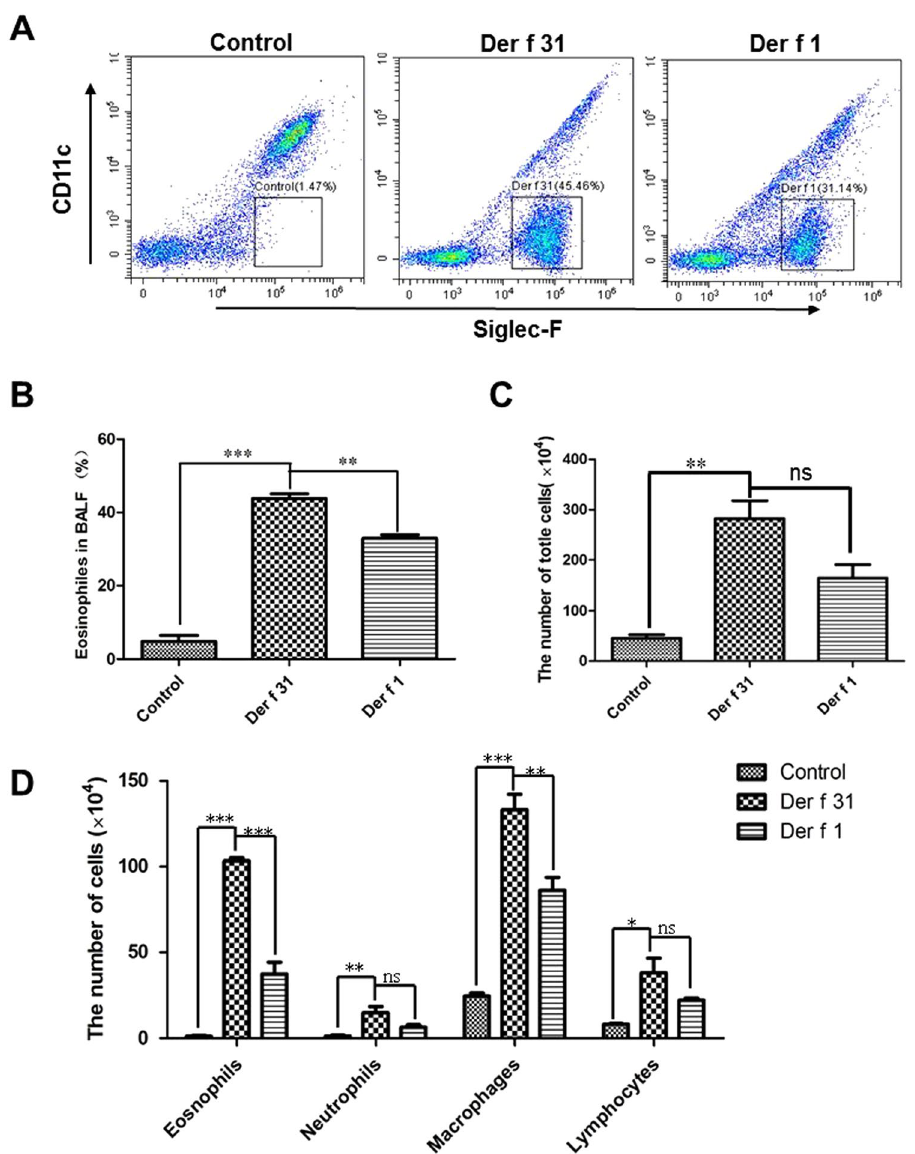
Figure 6. Der f 31 triggers an eosinophilia. ( A ) representative flow profile of Siglec-F + eosinophils in BALF. ( B ) statistics chart of FACS. ( C ) the total cell counts in the BALF. ( D ) Differential cell counts in the BALF. These data (means ± SEMs) were generated from one of three experiments (n = 4–6) and processed with GraphPad software. The significant differences between two groups were tested by two-tailed T-test. ** p < 0.01. *** p < 0.001. ns, no significant